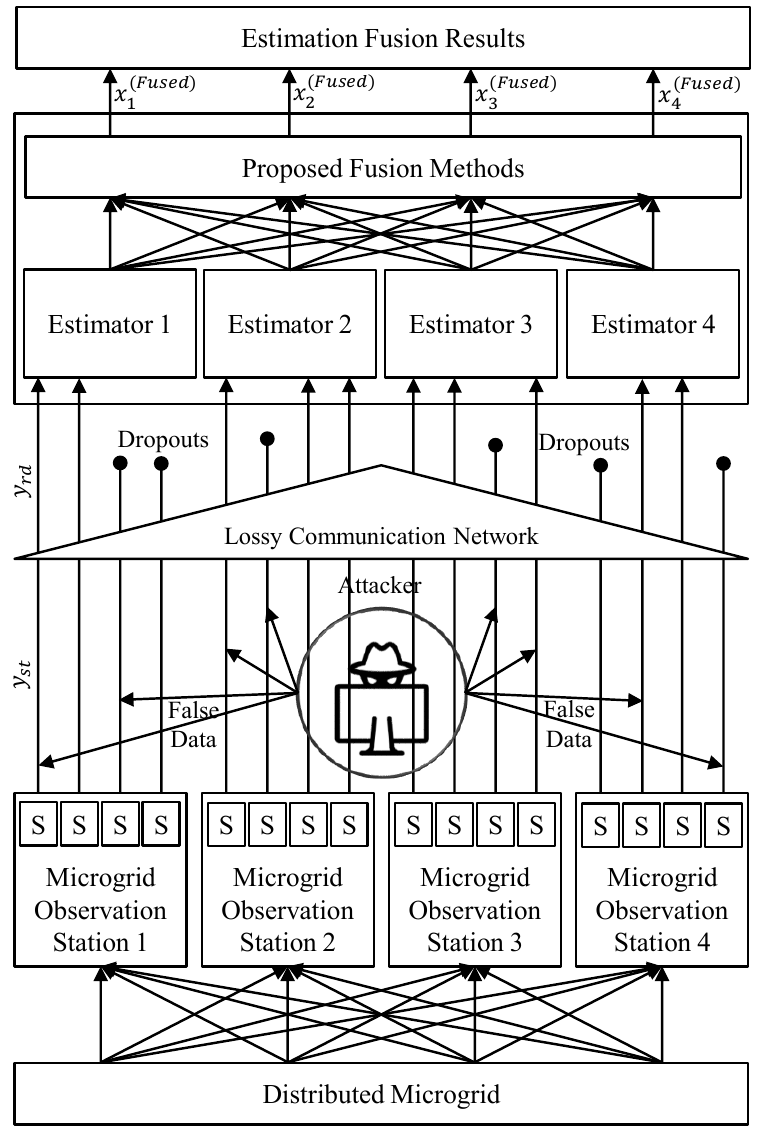
Figure 2. The proposed distributed microgrid state estimation and estimation fusion under cyberat- tack and packet loss (a significantly modified version of the benchmark structure given in